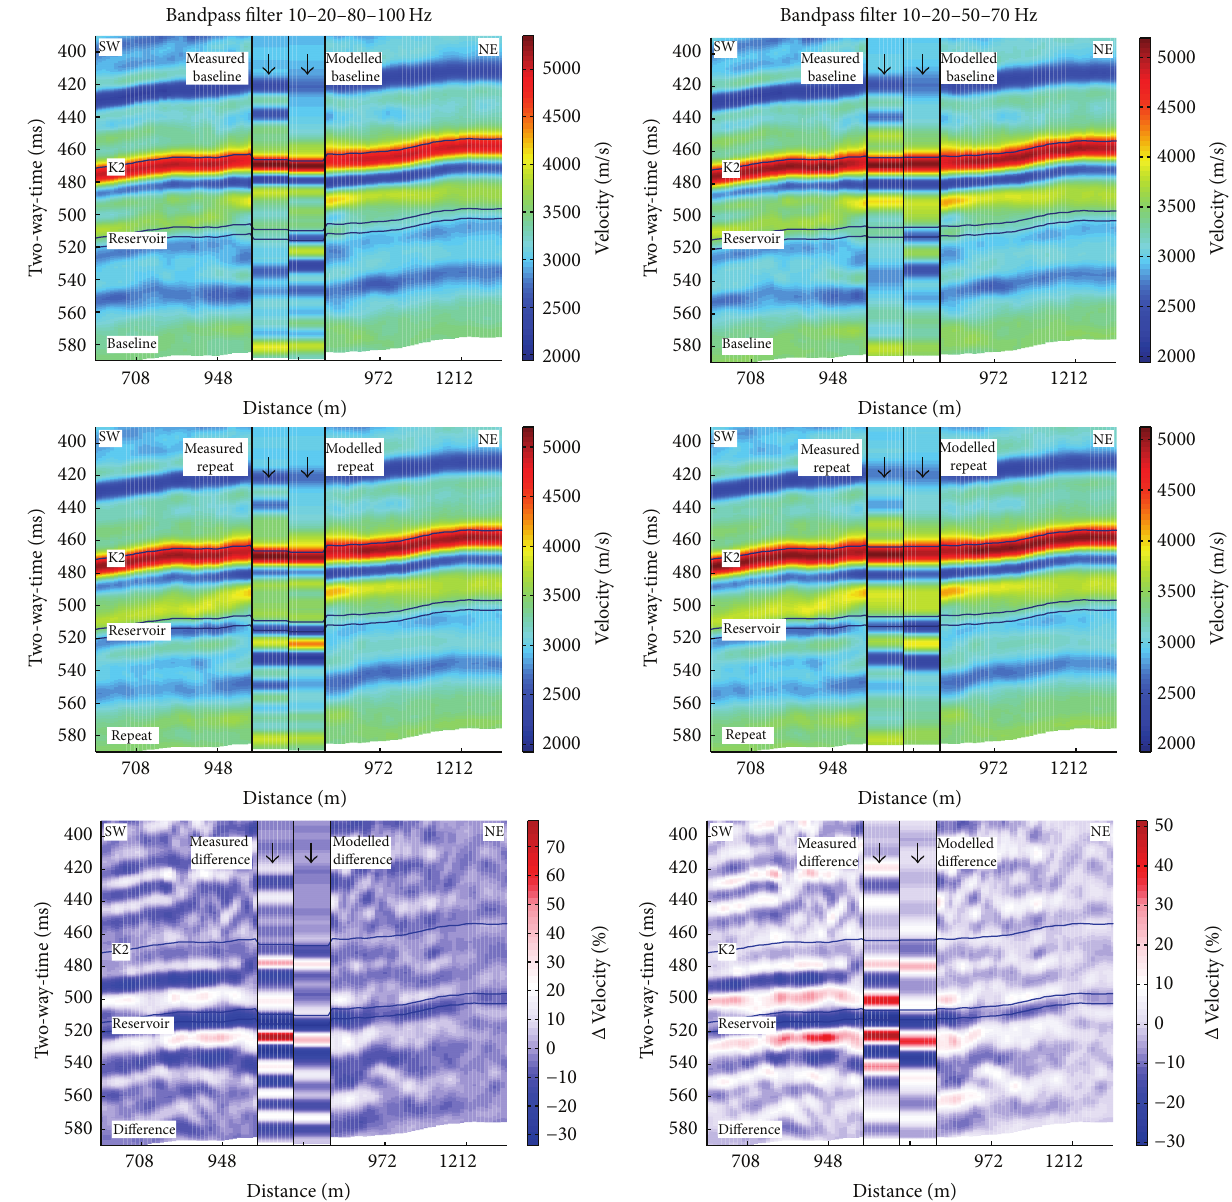
Figure 9: Result of the band limited impedance inversion of 3D surface seismic (inline 1172) and zero-offset VSP converted to P-wave velocities. The stacked traces of the zero-offset VSP data (measured and modelled) are plotted side by side and inserted at the intersection of inline 1172 with the well. From top to bottom: baseline, repeat, and difference (repeat minus baseline) in percent of the baseline velocity. The VSP data of the left column is bandpass filtered with corner frequencies of 10–20–80–100 Hz; the VSP data of the right column is bandpass filtered with corner frequencies of 10–20–50–70 Hz. The black lines mark the positions of the K2 (upper line), the top, and bottom of the reservoir (middle and bottom